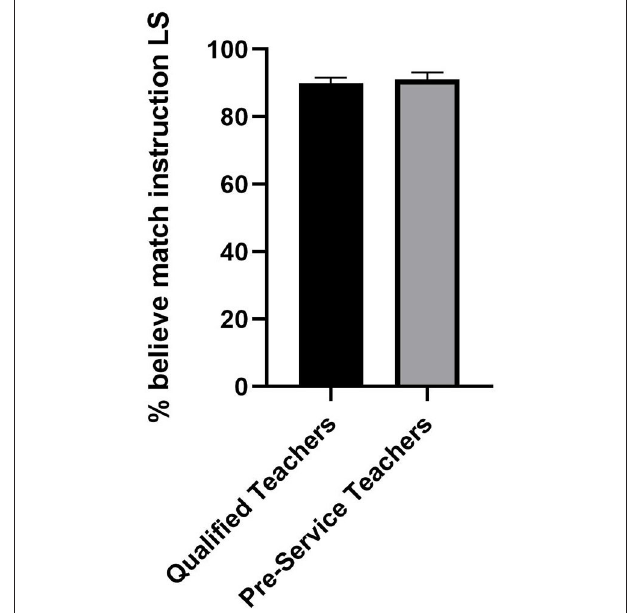
FIGURE 2 | No difference between the percentage of Qualified Teachers vs. Pre-Service Teachers who believe in the efficacy of matching instruction to Learning Styles. The percentage of educators who agreed with each statement was compared by Mann-Whitney U test. P = 0.529.